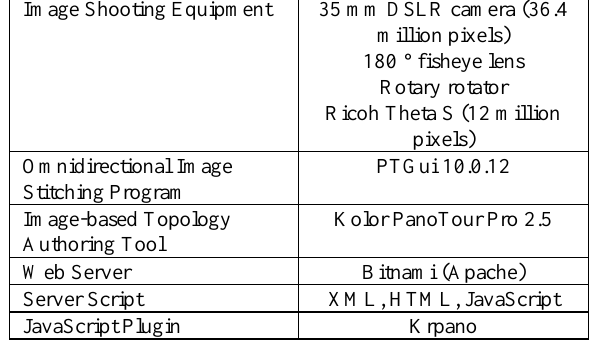
Table 1. Experimental Environment